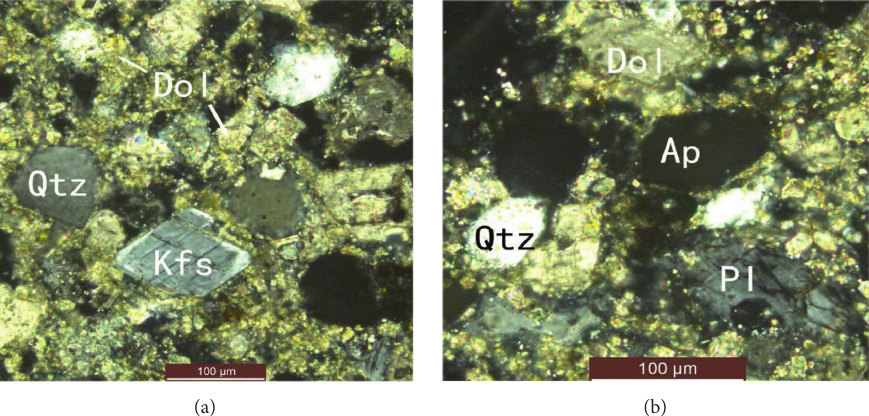
Figure 14: Embedded characteristics of silicate minerals (TCPL represents transmitted crossed polarized light). (a) Clastic potash feldspar